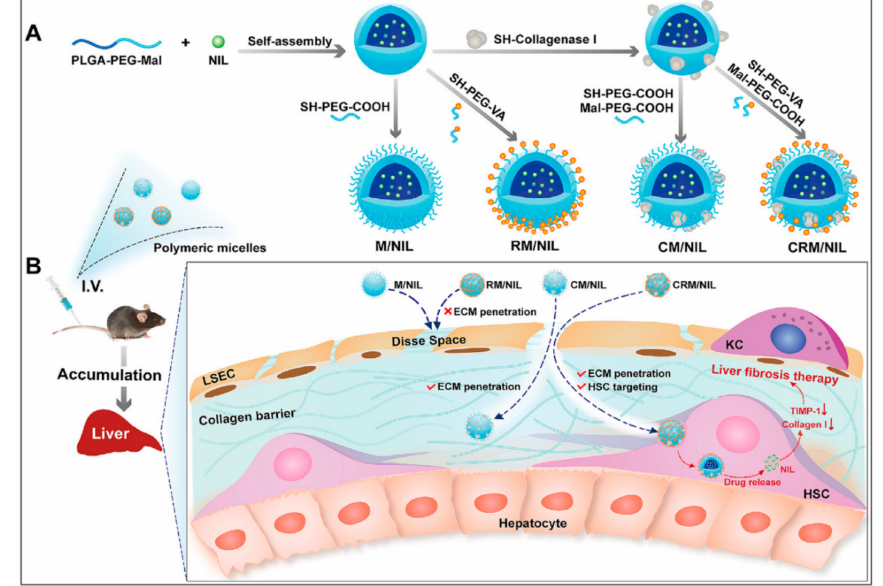
Figure 4. Extracellular matrix-penetrating polymeric micelles for liver fibrosis therapy. ( A ) Schematic illustration of the preparation of four di ff erent polymeric micelles. ( B ) Schematic illustration of the proposed destiny of the four di ff erent polymeric micelles in vivo. The CRM / NIL is able to